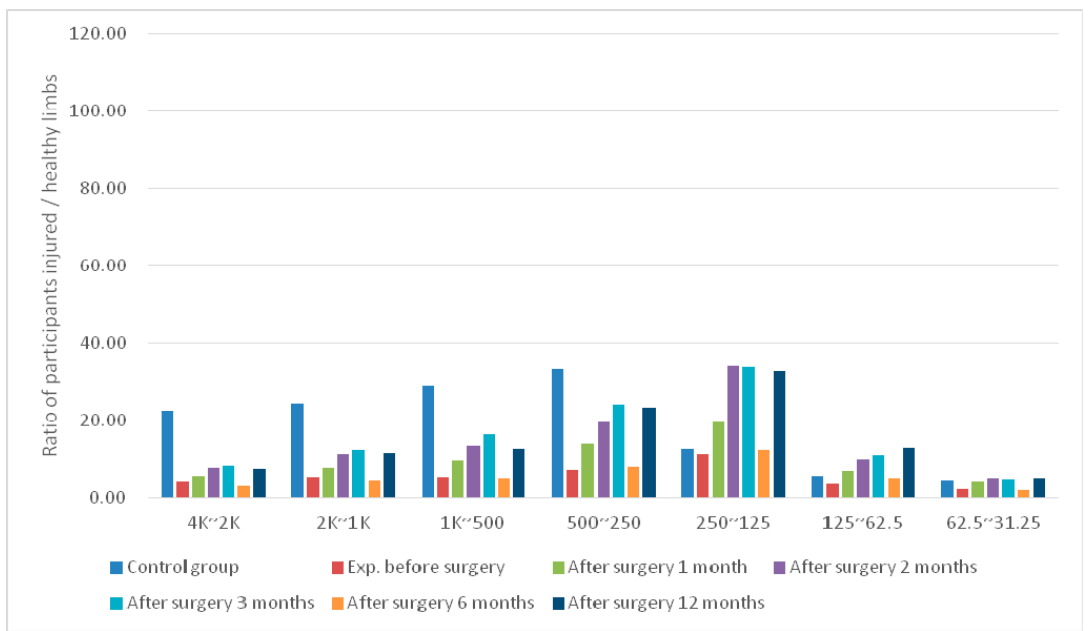
Figure 3. Average differences in signal bands at the MCL sensing point of postoperative knees in the experimental group. Appl. Sci. 2018 , 8 , x FOR PEER REVIEW